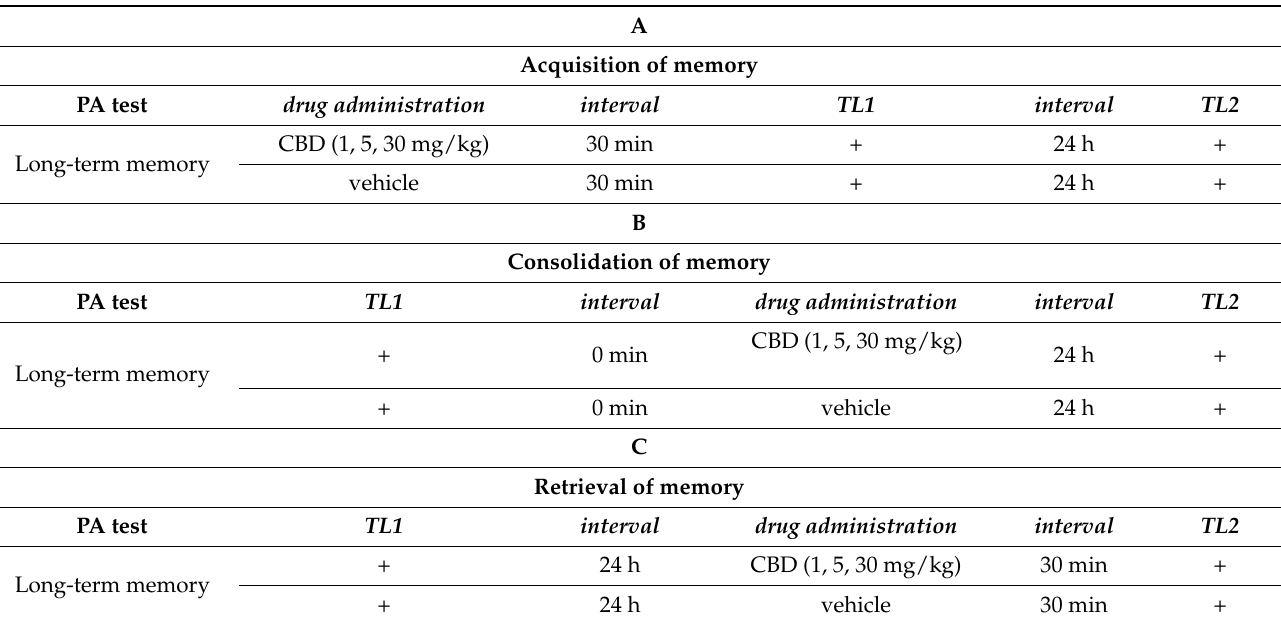
Table 1. The scheme of CBD or vehicle administration during the assessment of long-term memory acquisition (A), consolidation (B), or retrieval (C) in the PA test in mice; + test